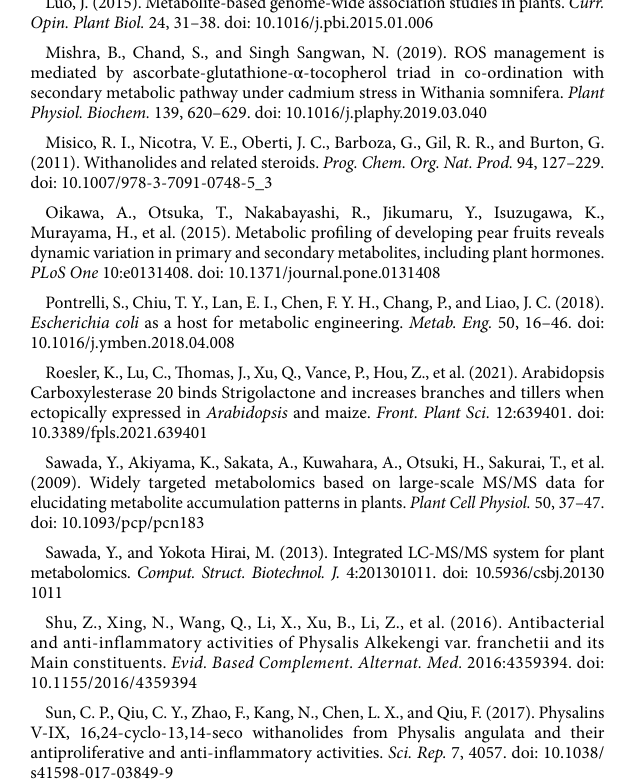
SUPPLEMENTARY FIGURE 6 Two fragmentation pathway in parent structure of